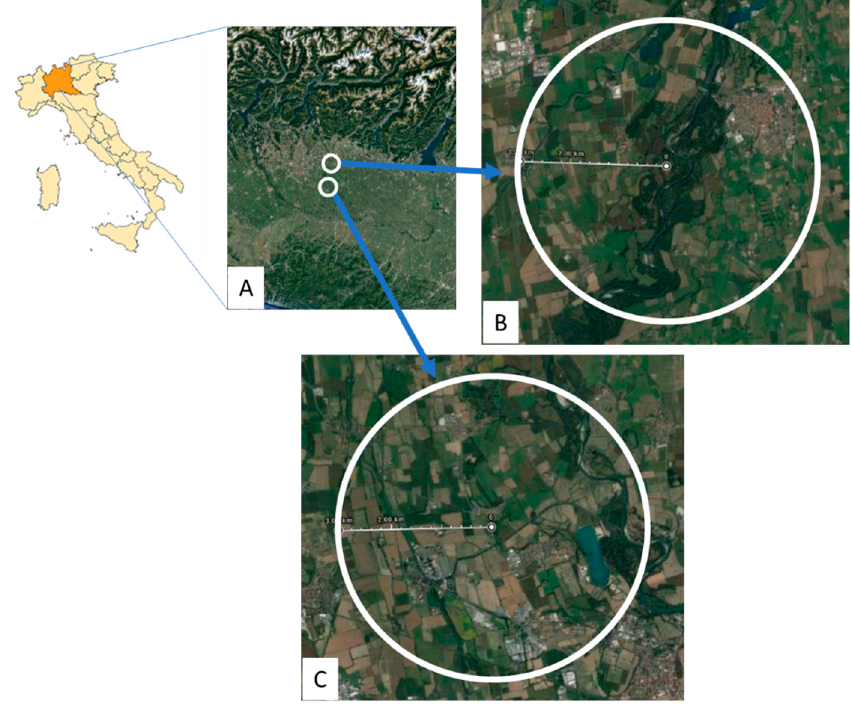
Figure 1. Satellite view of the experimental sites with a radius of 3 km around them; North Italy and Lombardy Region ( A ), control site at Corneliano Bertario ( B ) and exposure sites at Arcagna, centered in the same area at this scale ( C ) (https://www.google.it/maps visioned on 28 January 2021).